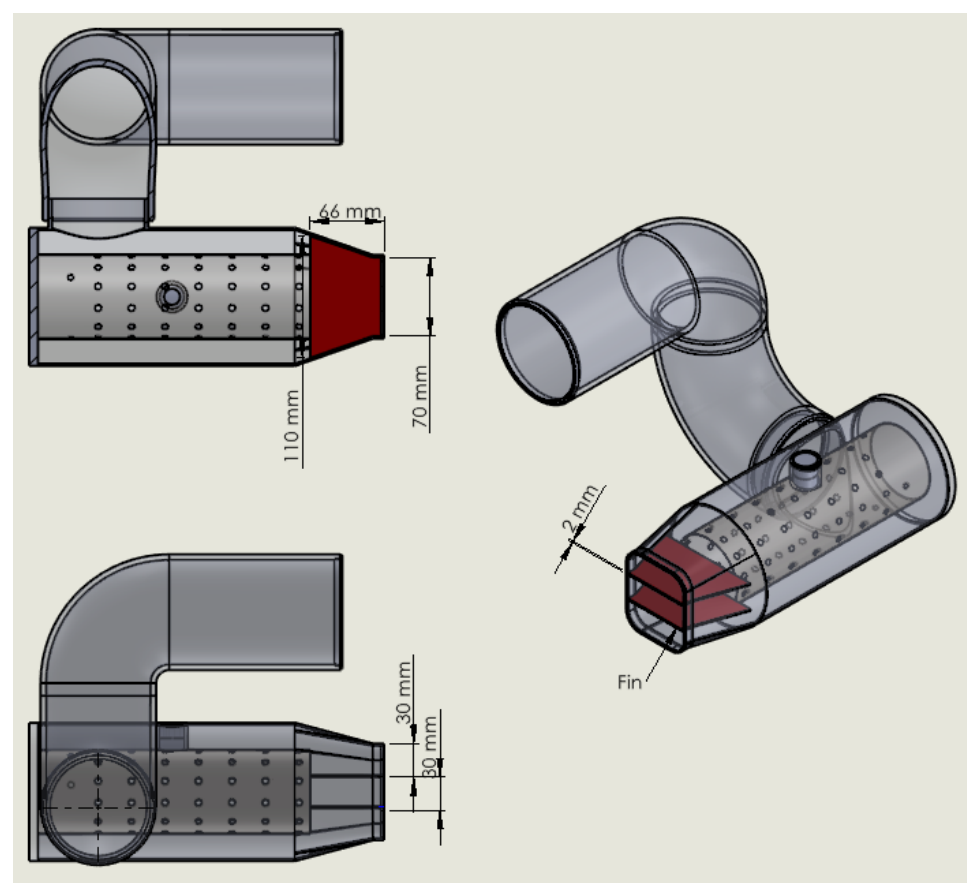
Figure 12. Details of the second fin added to the design.